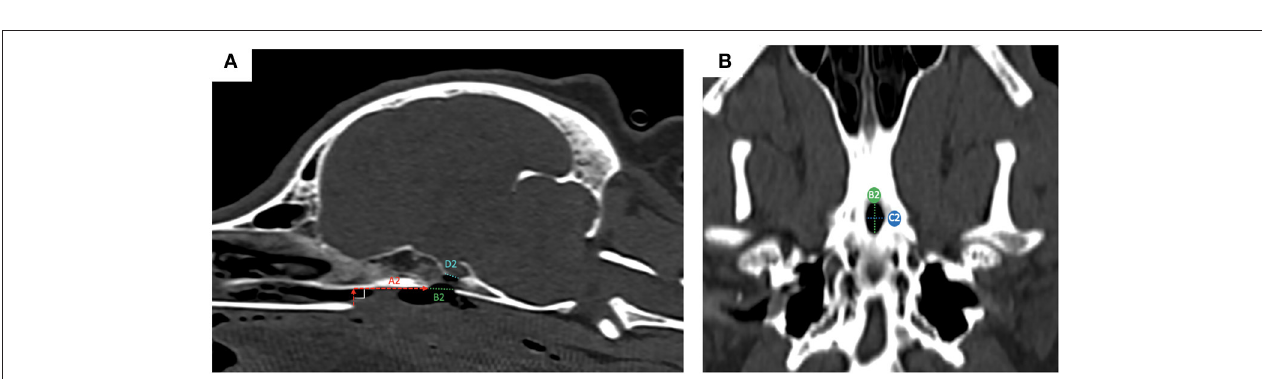
FIGURE 4 | post-operative measures from reconstructed sagittal CT images in a bone window; the measured obtained were: (A) the distance between the vomer and the rostral aspect of the achieved window in the basisphenoid outer cortex (A2, red dashed horizontal line); (ii) the length of bone removed from the outer cortical layer (B2, green dashed line) and the length of bone remove from the inner cortical layer (D2, light blue dashed line); (B) ventral view of the basisphenoid bone: the width (C2, blue dashed line) of the achieved window is visible, as well as the length (B2, green dashed